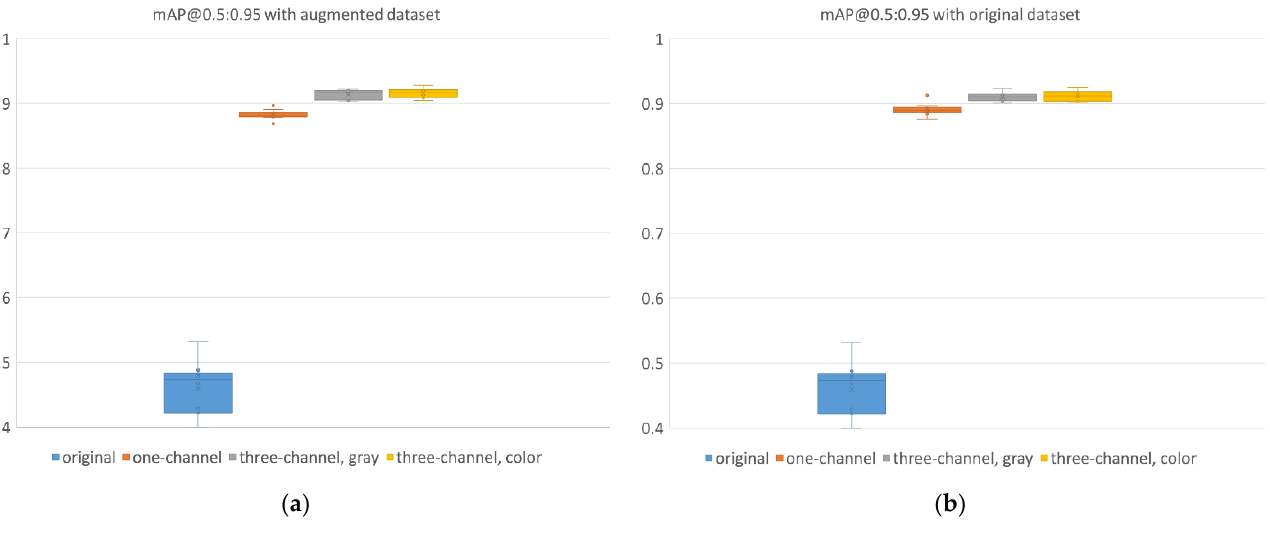
Table 12. YOLOv4-tiny object detection validation results with the augmented dataset.